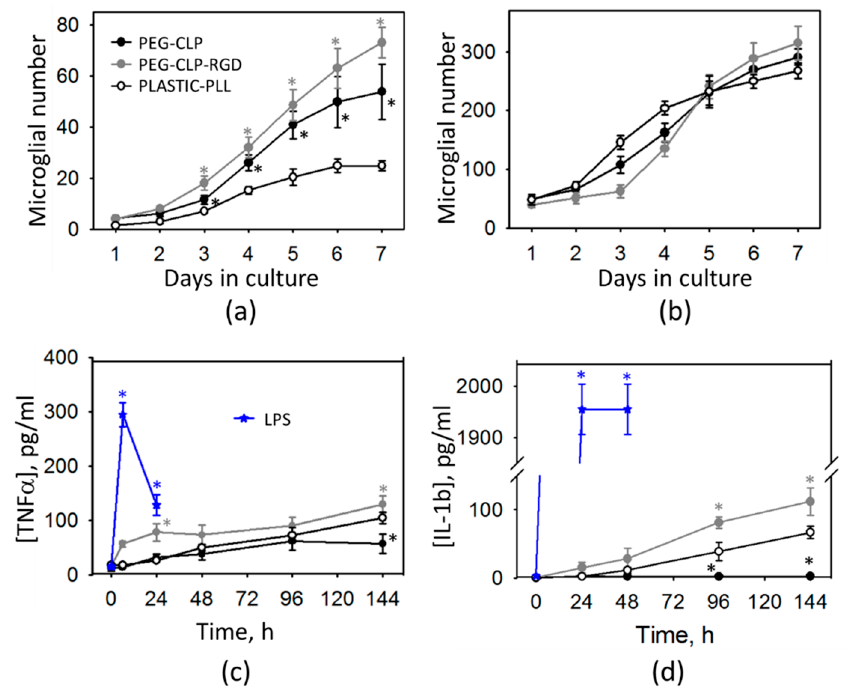
Figure 6. Increase in the microglial number on CLP-PEG and CLP-RGD-PEG hydrogels and poly-L-lysine (PLL)-covered plastic per microscopic image in mixed neuronal-glial ( a ) and pure microglial cultures ( b ); the amount of inflammatory cytokines TNF- α ( c ) and IL-1 β ( d ) in the medium of neuronal-glial cells on both hydrogels and plastic. LPS (lipopolysaccharide)—cells on the PEG-CLP hydrogel were activated by adding 100 ng/mL lipopolysaccharide for the positive control of cytokine release. The data are presented as averages of 3–5 experiments with standard error. Statistical analysis: one way ANOVA; *—statistically significant difference compared to Plastic-PLL; p ≤ 0.01.